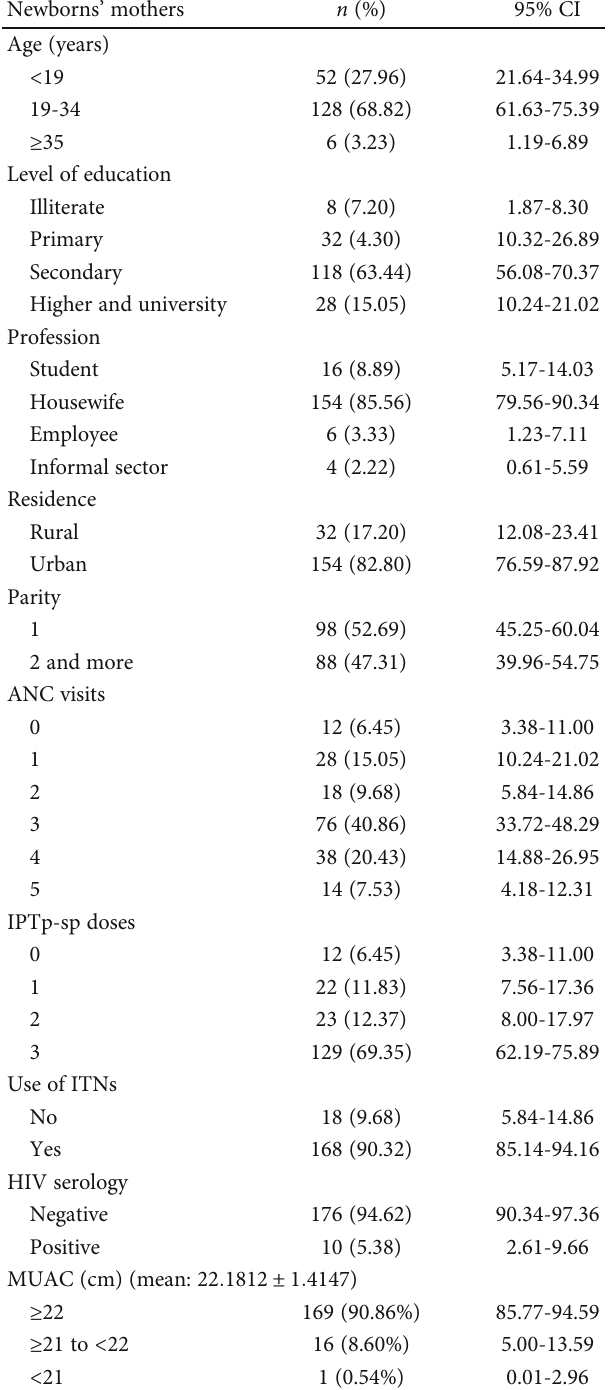
Table 1: Characteristics of newborns ’ mothers who had placental parasitaemia ( N = 186 ).